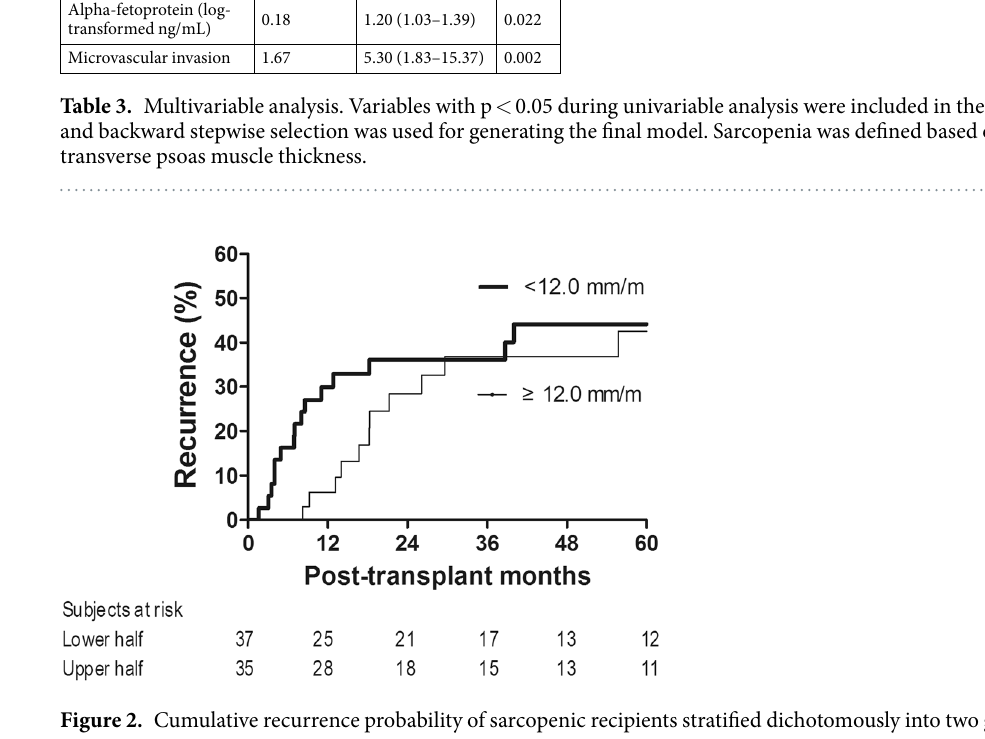
Figure 2. Cumulative recurrence probability of sarcopenic recipients stratified dichotomously into two